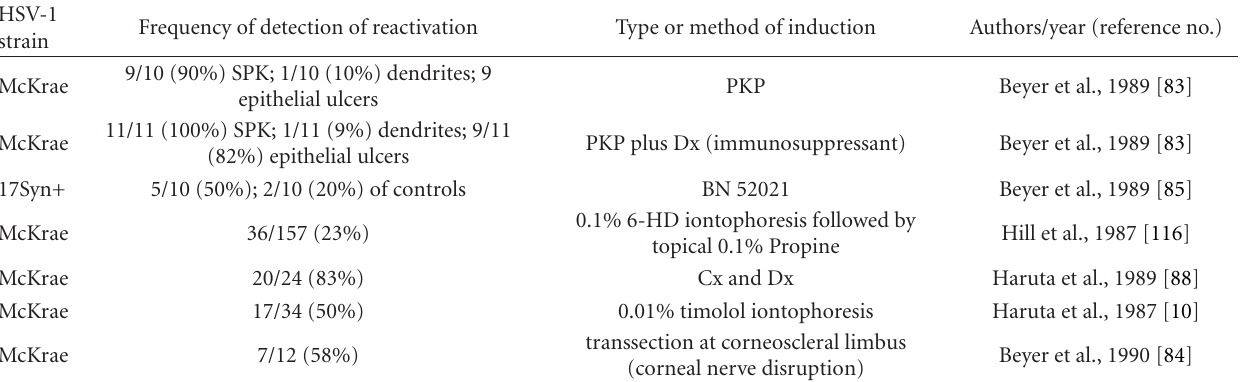
Table 8: Induced recurrent corneal lesions in HSV-1 latently infected